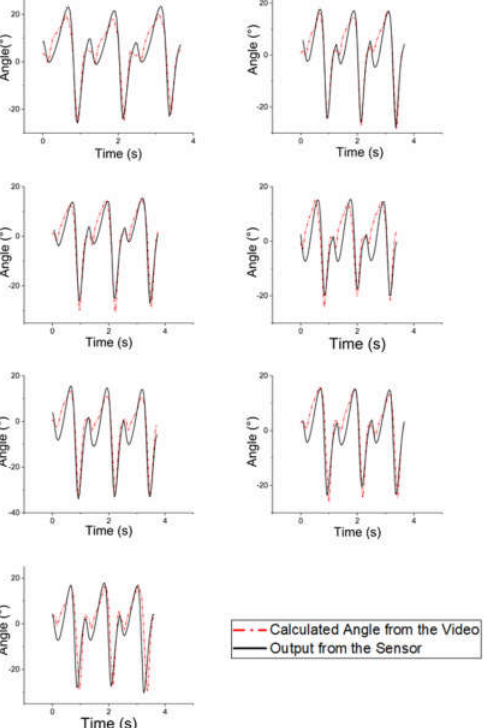
Figure 9. Gait analysis of the first subject. Figures are in the order of the thicknesses (6, 8, 10, 12 mm) and lengths (32, 40, 57 mm) of each